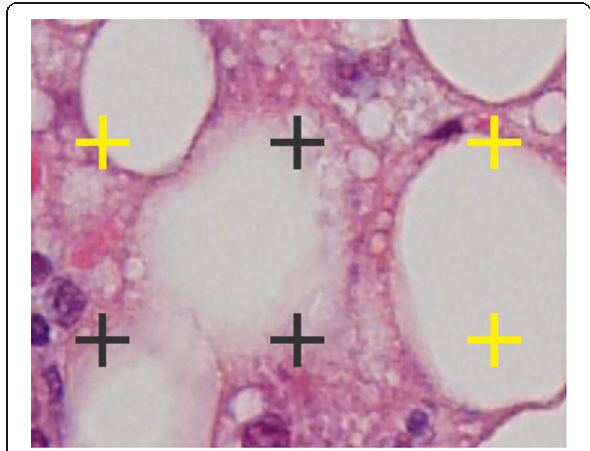
Fig. 8 Edge Ambiguity. Because of the thickness of tissue sections, it is often ambiguous whether points lie within or outside of fat